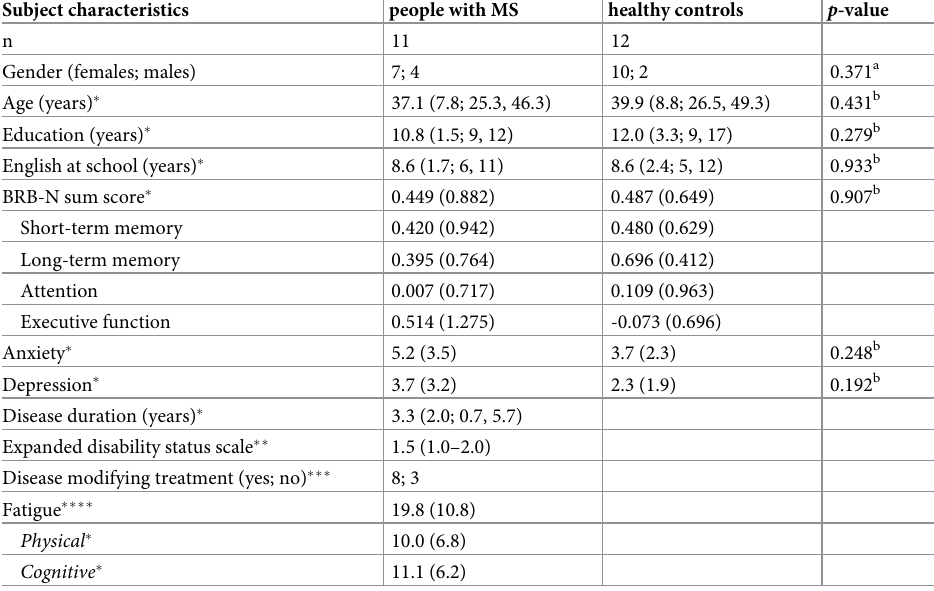
Table 2 details baseline characteristics of the whole cohort. There was a pronounced female predominance (64%) and the majority of pwMS (73%) was on a disease modifying treatment Table 2. Baseline characteristics of study